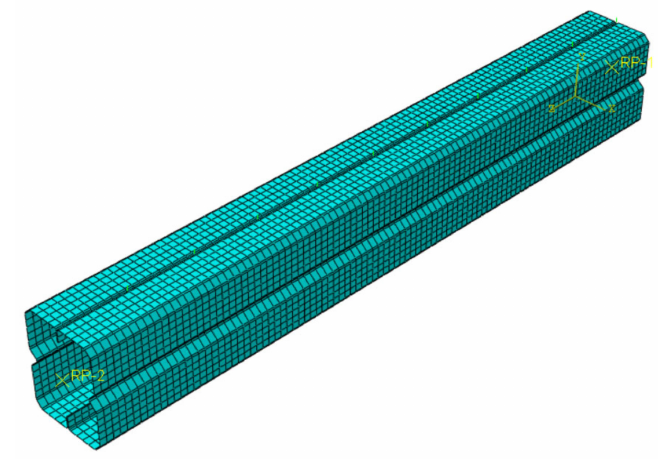
Figure 11. FE meshing for